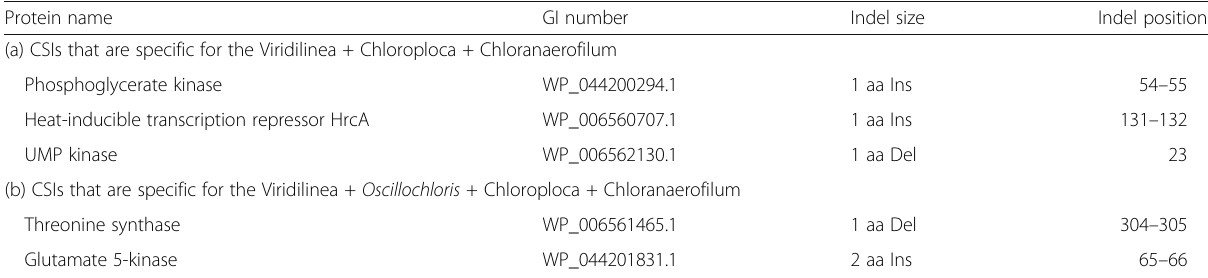
Table 6 CSIs that are specific for O. trichoides , ‘ Ca . Chloranaerofilum corporosum ’ , O. trichoides , ‘ Ca . Chloroploca asiatica ’ and ‘ Ca .